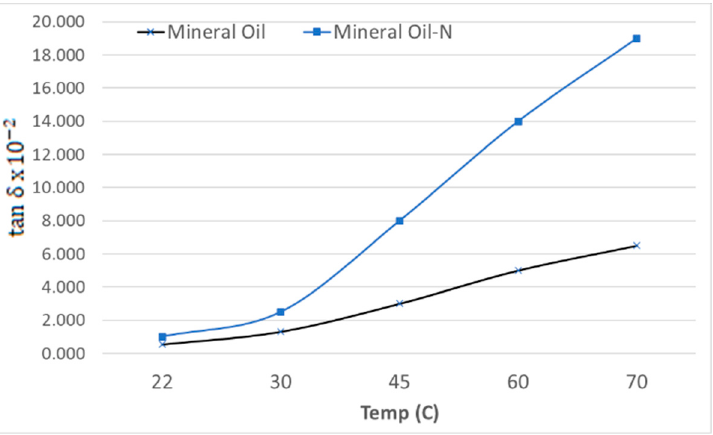
Figure 6. Variation of tan δ as a function of temperature.